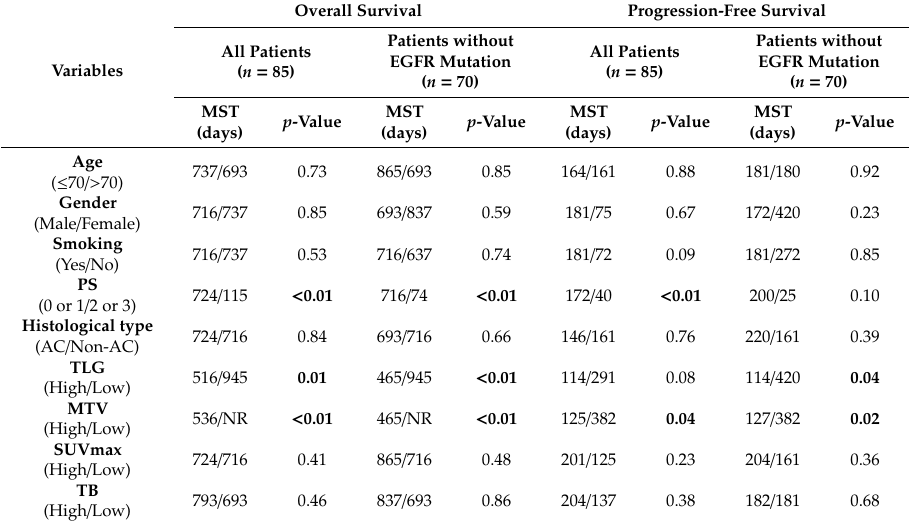
Table 2. Univariate analysis in overall survival and progression-free survival.